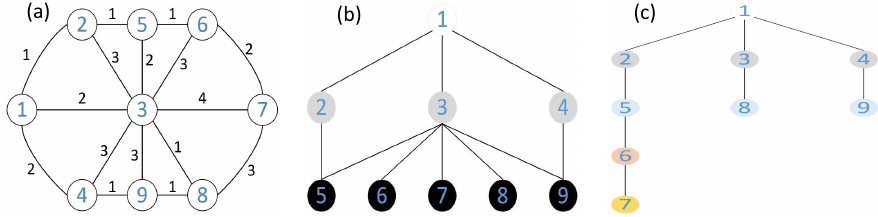
Figure 2. Distance estimation methods. ( a ) graph network; ( b ) minimum hop path algorithm; ( c ) shortest path